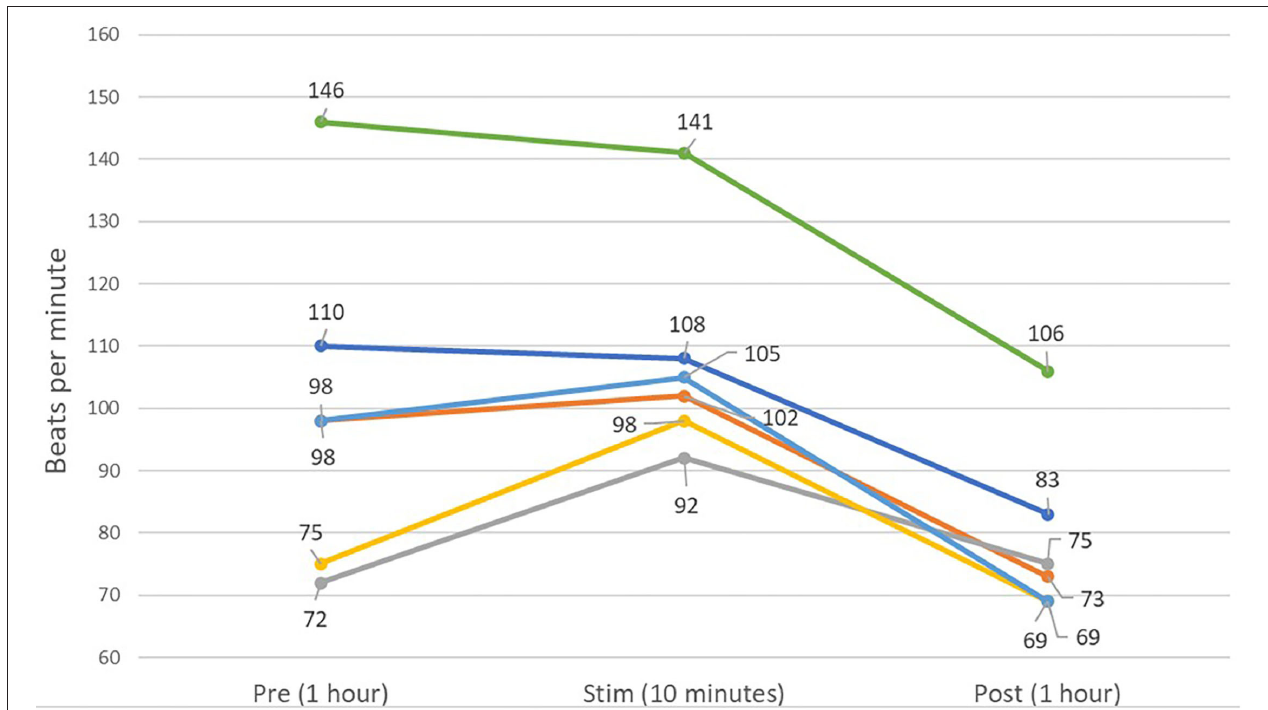
FIGURE 9 | Line graph showing the averaged mean heart rates of the 6 dogs over 1h of pre-stimulation (Pre) and post-stimulation (Post), as well as the averaged mean heart rate of the 10min of the peri-stimulation period. A decreased mean heart rate is present in the post-stimulation period for five of six